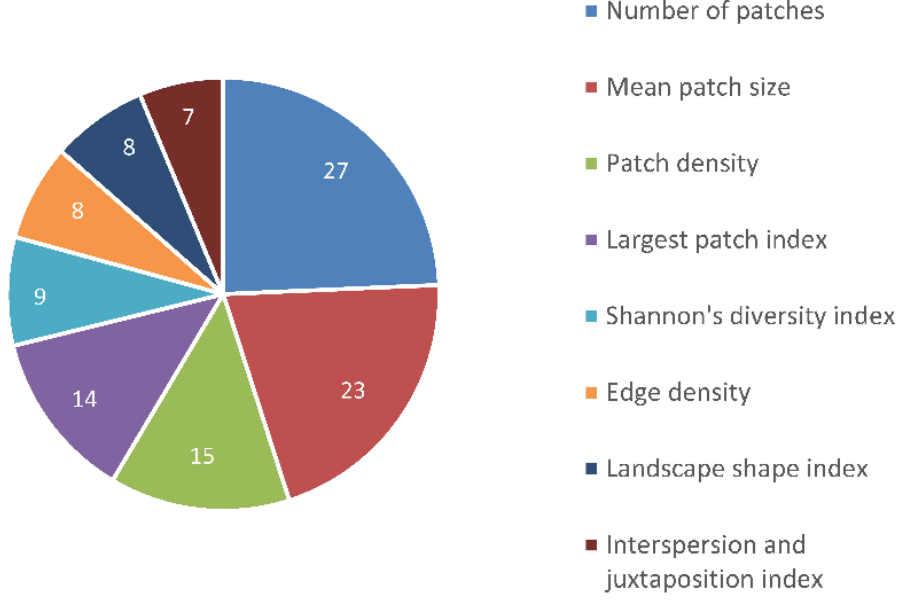
Figure 12. Most-used calculated landscape metrics by number of manuscripts. Own elaboration.